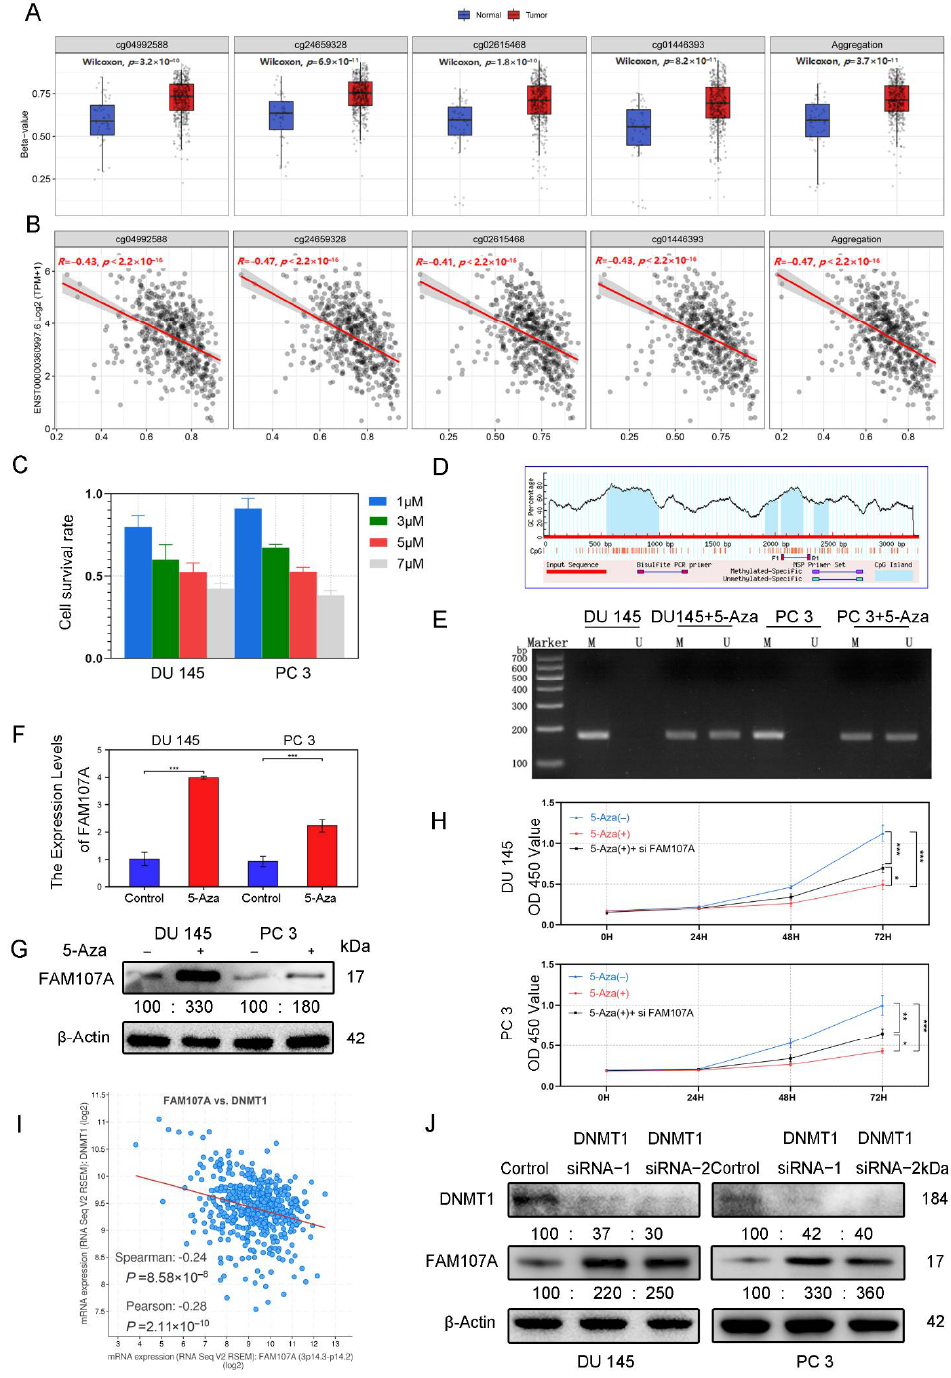
Figure 3. FAM107A exhibits low expression in prostate cancer cells due to hypermethylation of its promoter region. ( A ) cg04992588, cg24659328, cg2615468, and cg01446993 were used as probes to